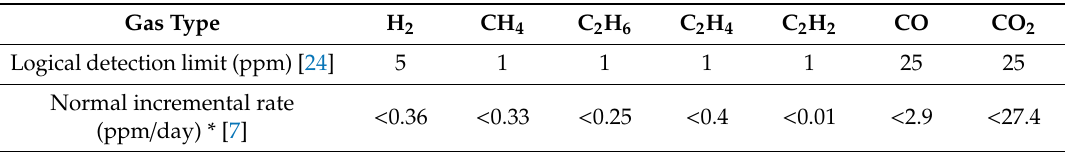
Table 1. Dissolved gas analysis (DGA) analytical detection limit and normal incremental rate per day